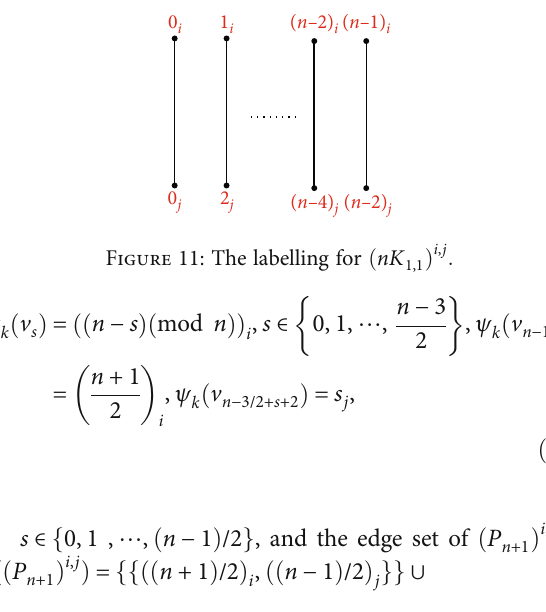
Figure 9: The labelling for ð 2 K